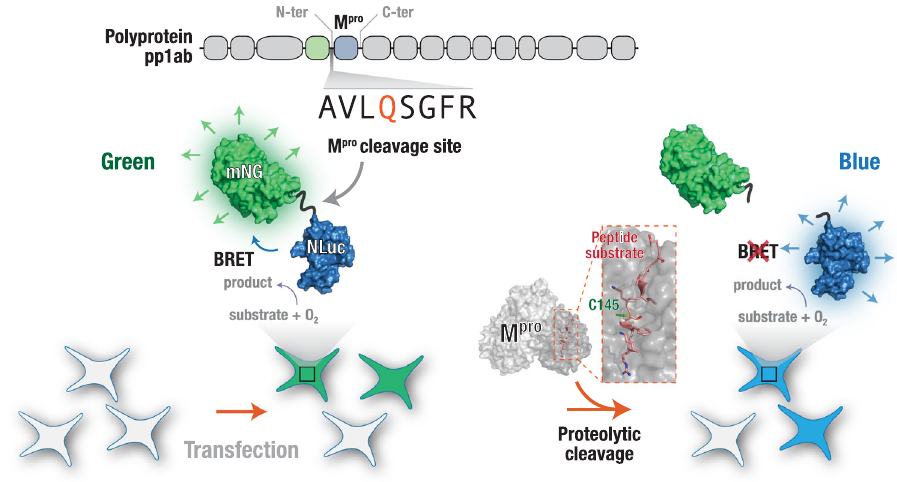
Fig. 1 Genetically encoded, BRET-based live cell SARS-CoV-2 M pro protease activity sensor. A schematic representation of the genetically encoded, BRET-based SARS-CoV-2 M pro protease activity sensor expressed in live cells. Close positioning of the NLuc (BRET donor) and mNG (BRET acceptor) proteins result in a signi fi cant resonance energy transfer in the absence of the SARS-CoV-2 M pro protease activity. Activity of the SARS-CoV-2 M pro results in the cleavage of the sensor resulting in a decrease in the resonance energy transfer between NLuc and mNG leading to a decrease in the green fl uorescence of the sensor. Shown in gray is the surface representation of M pro structure (SARS-CoV; PDB: 2Q6G 68 ) highlighting the critical C145 residue (green) required for proteolytic activity and the substrate peptide (TSAVLQSGFRK;